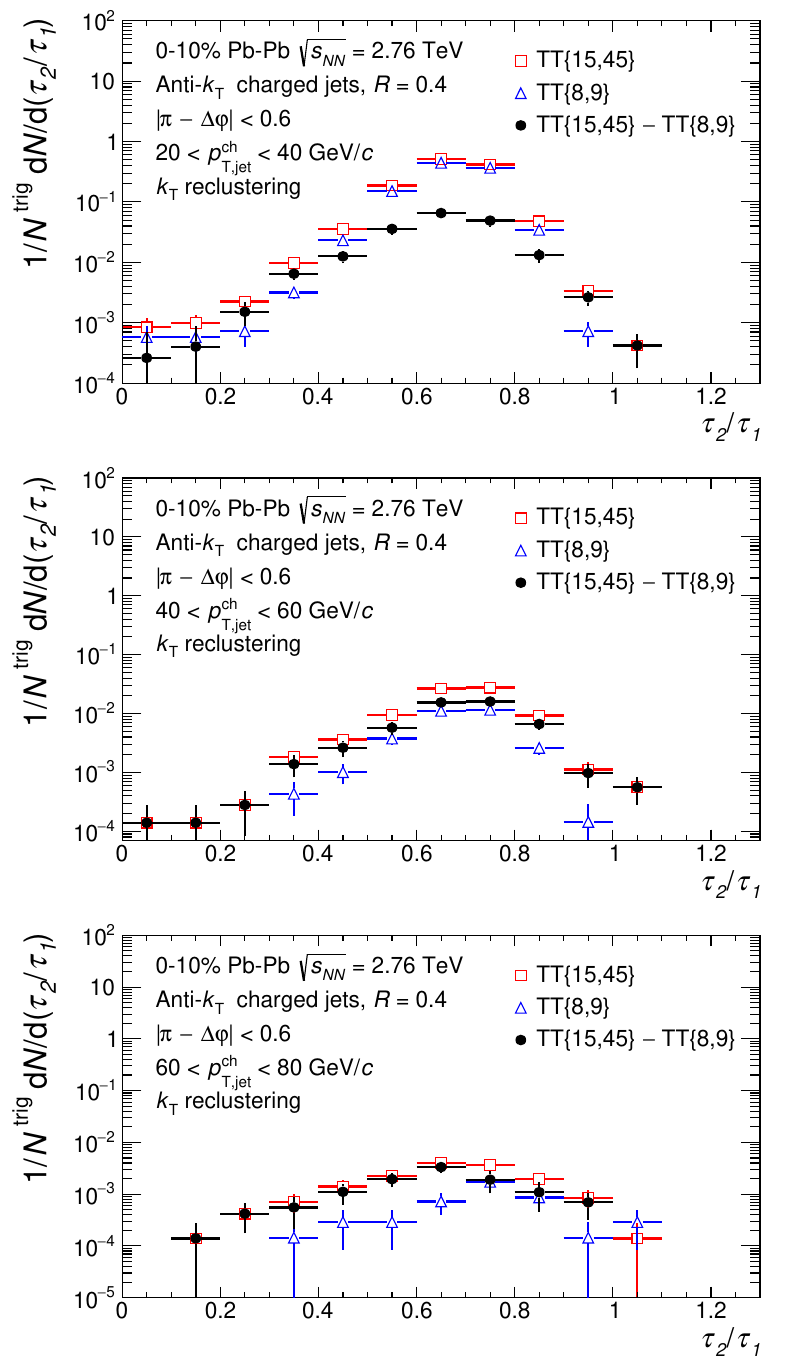
Figure 4 . The uncorrected τ 2 /τ 1 distributions of the jets recoiling from a trigger hadron, mea- √ sured in Pb-Pb collisions at s NN = 2 . 76 TeV, are presented. For each trigger hadron class, three consecutive uncorrected p ch bins of 20 ≤ p ch < 40 , 40 ≤ p ch < 60 and 60 ≤ p ch < 80 GeV/ c T , jet T , jet T , jet T , jet are measured. The red, blue and black data points represent the signal trigger class, the reference trigger class and the difference between the two classes,